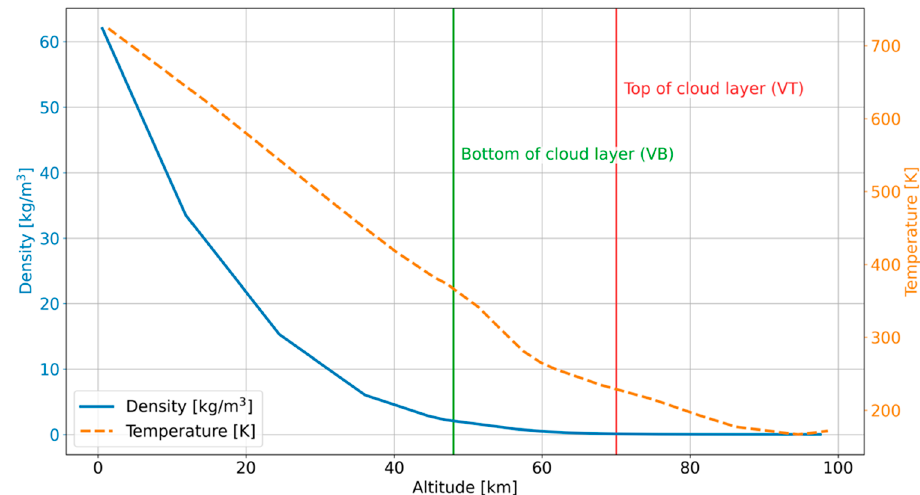
Figure 3. Venusian atmosphere. Atmospheric density (blue solid line) is plotted against the left-hand scale; atmospheric temperature (orange dashed line) is plotted against the right-hand scale. The approximate heights of the bottom (labelled VB, green) and top (labelled VT, red) of the cloud layer are indicated by vertical lines.